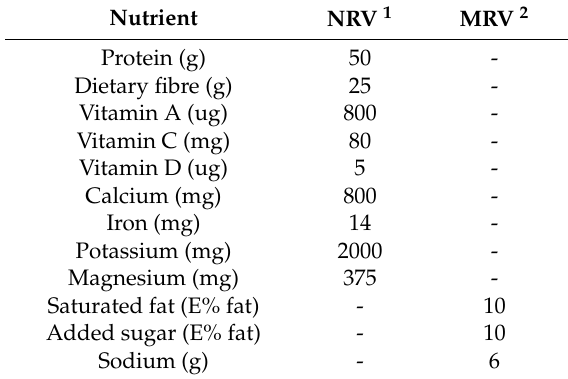
Table 1. The reference daily values and maximum recommended values for nutrients based on a 2000-kcal